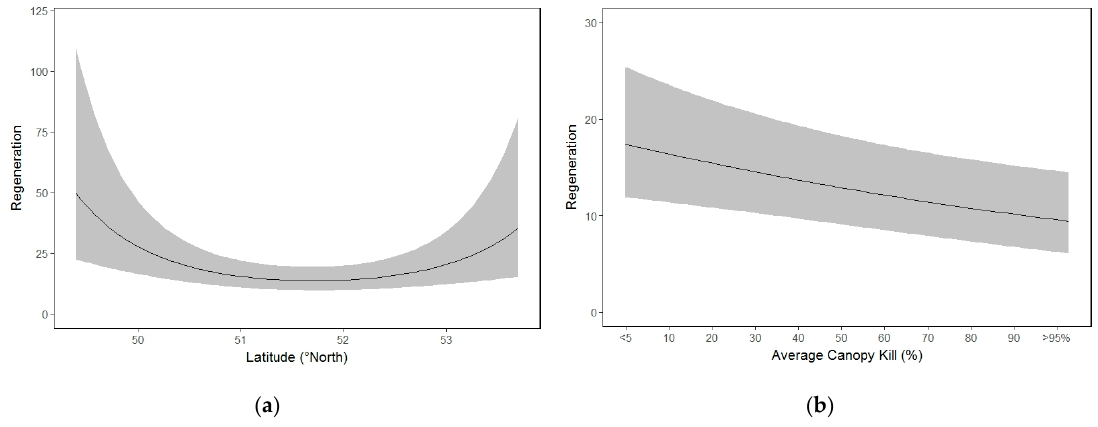
Figure 10. Seedling regeneration (counts) by latitude ( a ) and average canopy kill per plot ( b ) in 2014, estimated by holding other predictor variables at their mean values for a 500 m 2 plot.